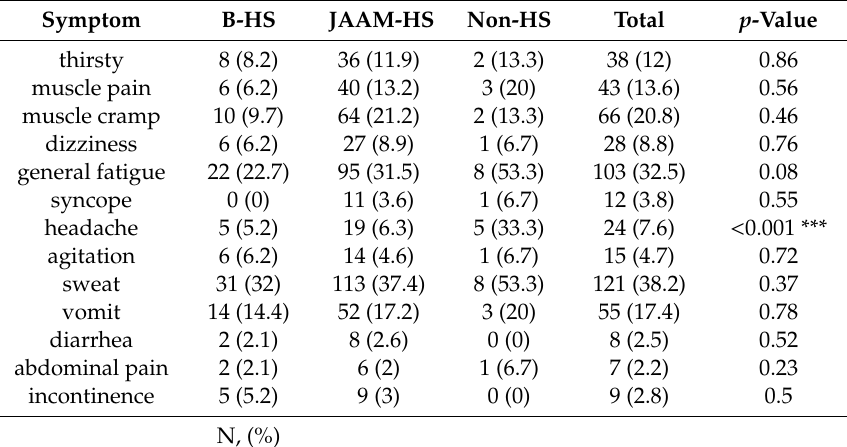
Table 3. Clinical manifestations of the B-HS, JAAM-HS, and non-HS patients.